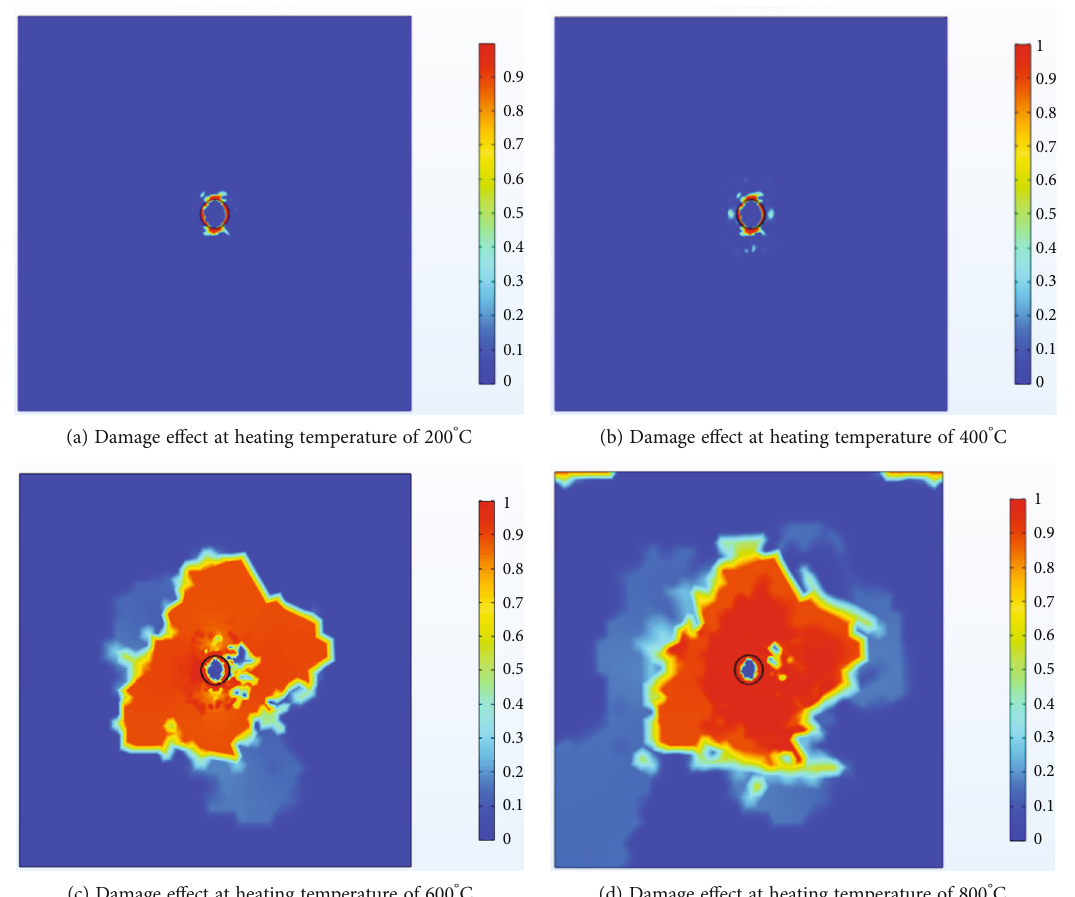
Figure 3: Damage e ff ect of coal body under di ff erent heating